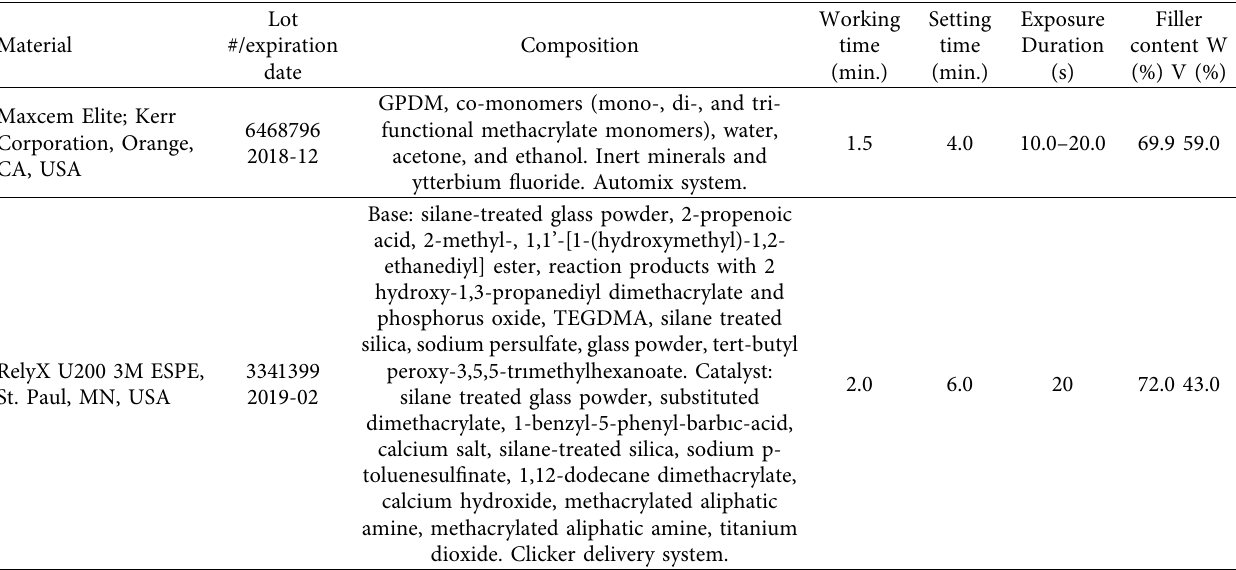
Table 1: Materials used in this